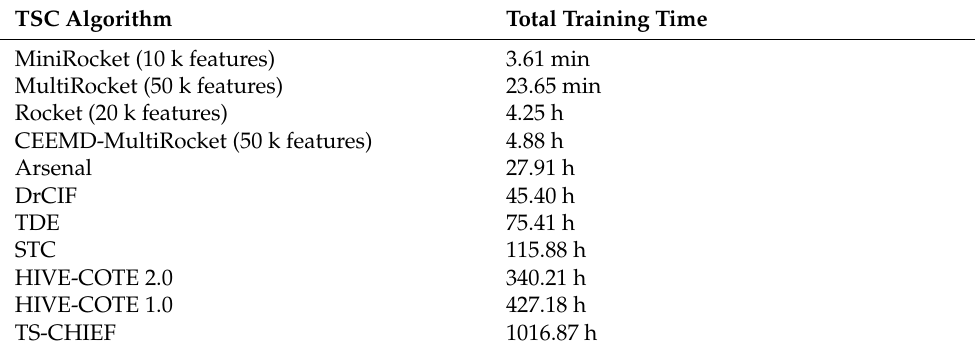
Table 4. Runtime to train single resample of 112 UCR datasets. The runtime of Rocket family and CEEMD-MultiRocket algorithm is calculated by running with a single thread on Intel Xeon Gold 5218 CPU. The runtime of the others is cited from